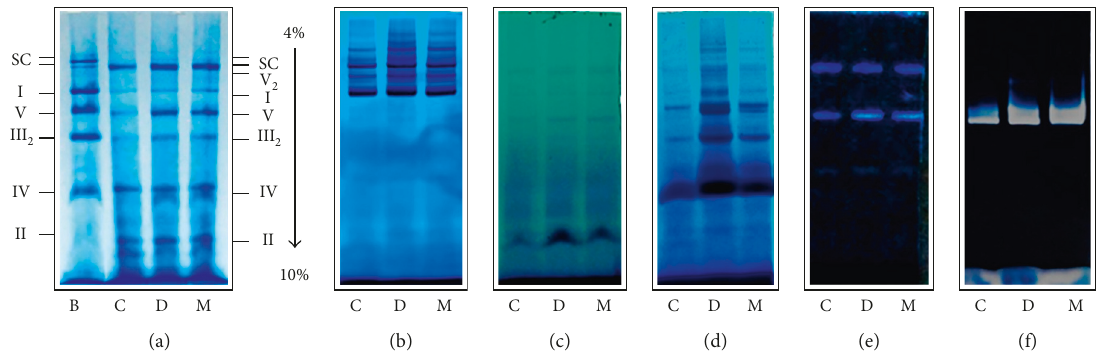
Figure 3: Electrophoretic representative pattern of liver mitochondrial solubilized of the different groups (5g de digitonin/g protein). (a) Blue native polyacrylamide gel electrophoresis (BN-PAGE) stained with Coomassie blue; (b) complex I in-gel activity; (c) complex II in- gel activity; (d) complex IV in-gel activity; (e) complex IV in-gel activity; (f) high resolution clear native polyacrylamide gel electrophoresis (hrCN-PAGE) of complex V. B: bovine heart solubilized mitochondria (positive control); C: control; D: diabetic; M: Moringa -treated diabetic